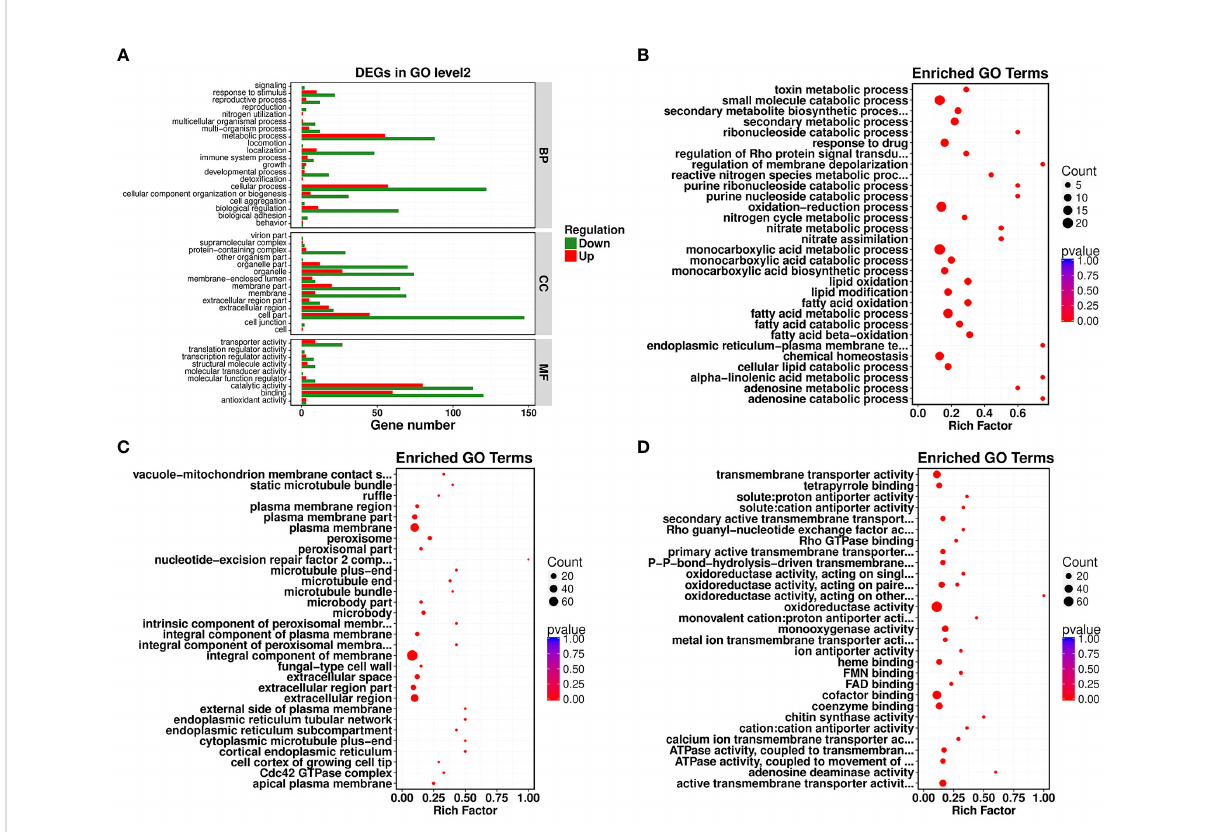
FIGURE 2 Gene Ontology (GO) enrichment analysis of PCN-related DEGs. (A) GO functional classi fi cation; (B) biological process (BP); (C) cellular component (CC); (D) molecular function (MF).